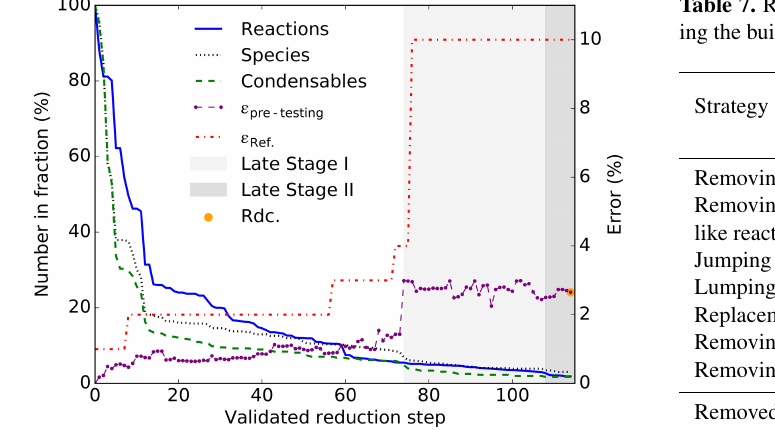
Figure 4. Reduction process of the Rdc. mechanism showing the decrease in the number of reactions, species, and condensables; the evolution of the average error on the pre-testing dataset ( (cid:15) pre − testing , with an error tolerance (cid:15) ave of 3%); and the error tolerance pre − testing compared with MCM ( (cid:15) ref ).